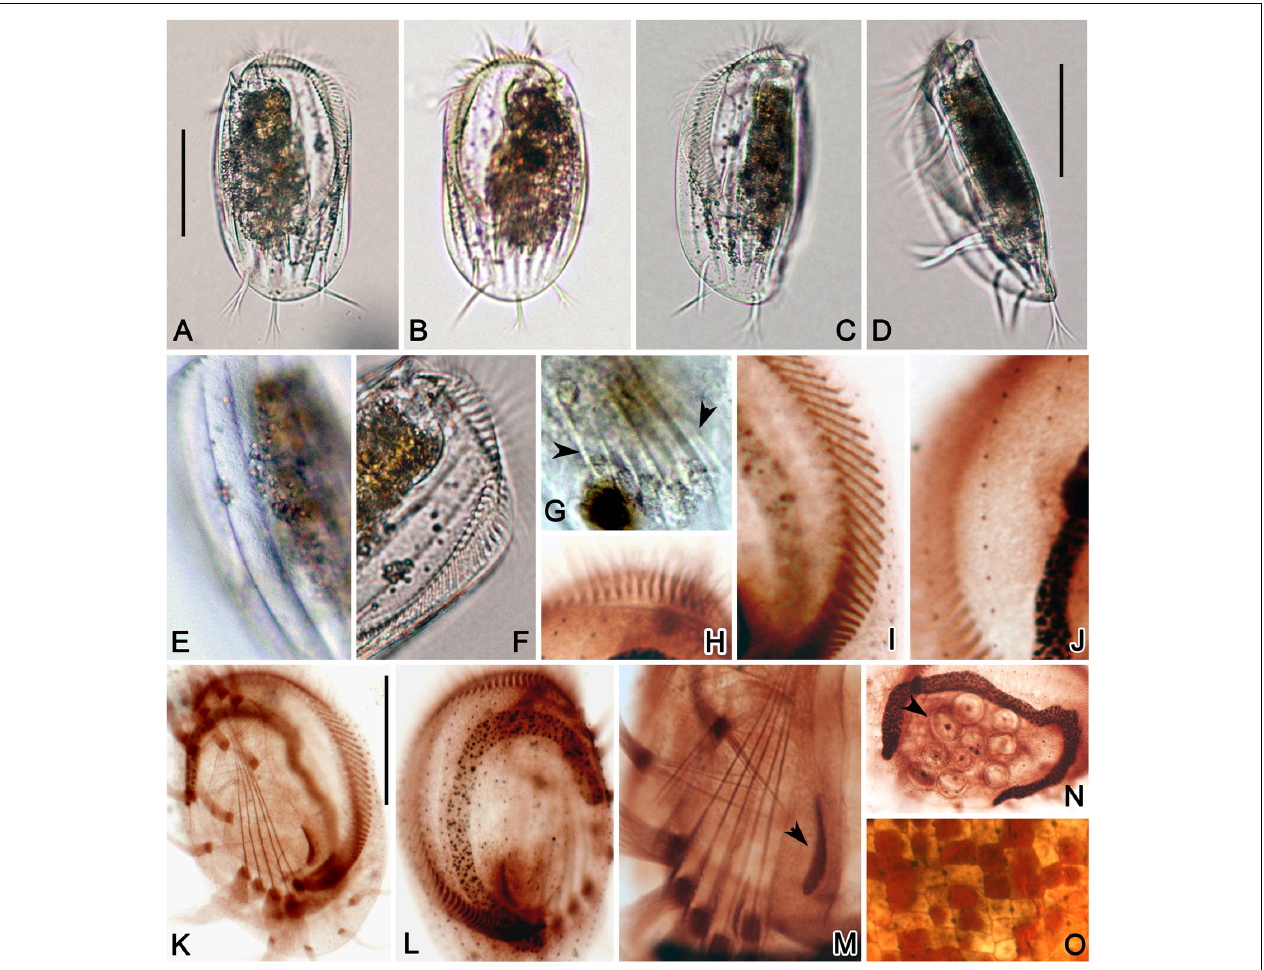
FIGURE 2 | Photomicrographs of E. neapolitanus in vivo (A–G) , and after protargol (H–N) and silver nitrate (O) impregnation. (A,B) Ventral (A) and dorsal (B) views of typical specimens. (C,D) Left-dorsal (C) and lateral (D) views. (E) Detail of dorsal side to show the ridges. (F) Anterior part of ventral side showing the abruptly curved AZM. (G) Detail of ventral side, arrowheads show the short ridge between transverse cirri. (H,I) Anterior (H) and middle (I) portions of AZM. (J) Detail of dorsal kinety. (K,L) Ventral (K) and dorsal (L) views of infraciliature. (M) Center portion of ventral side to show the transverse cirri, paroral membrane (arrowhead) and developed fiber system around the cirri. (N) Macronucleus and food (arrowhead) in cell center. (O) Detailed dorsal view of silverline system. Scale bars = 50 µ m.